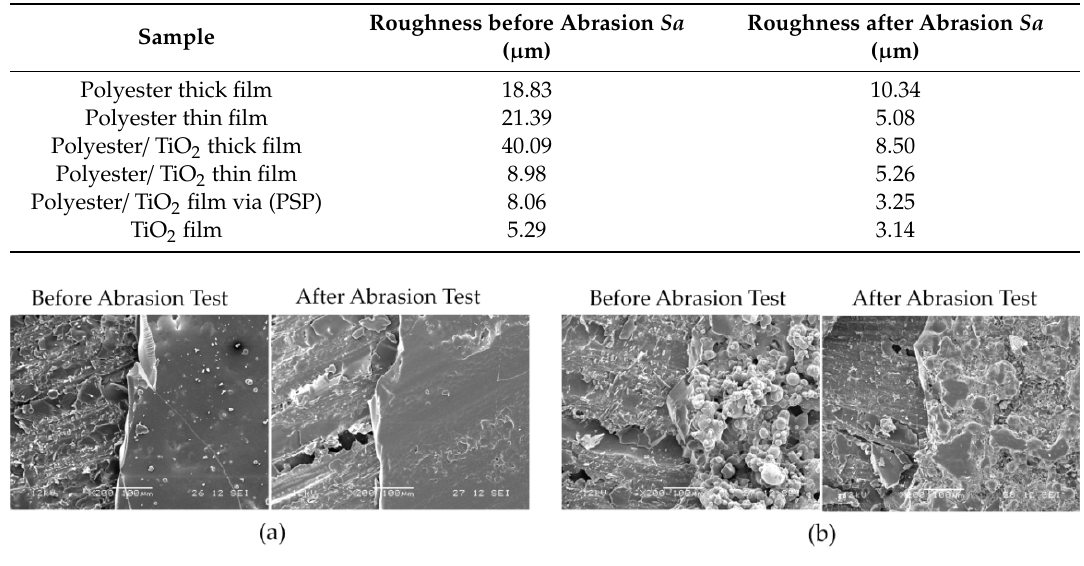
Figure 9. SEM images at magnification of 200x (scale bar 100 µ m) of cross-sections before and after abrasion test of: ( a ) polyester thick film; ( b ) polyester/TiO 2 thick film.